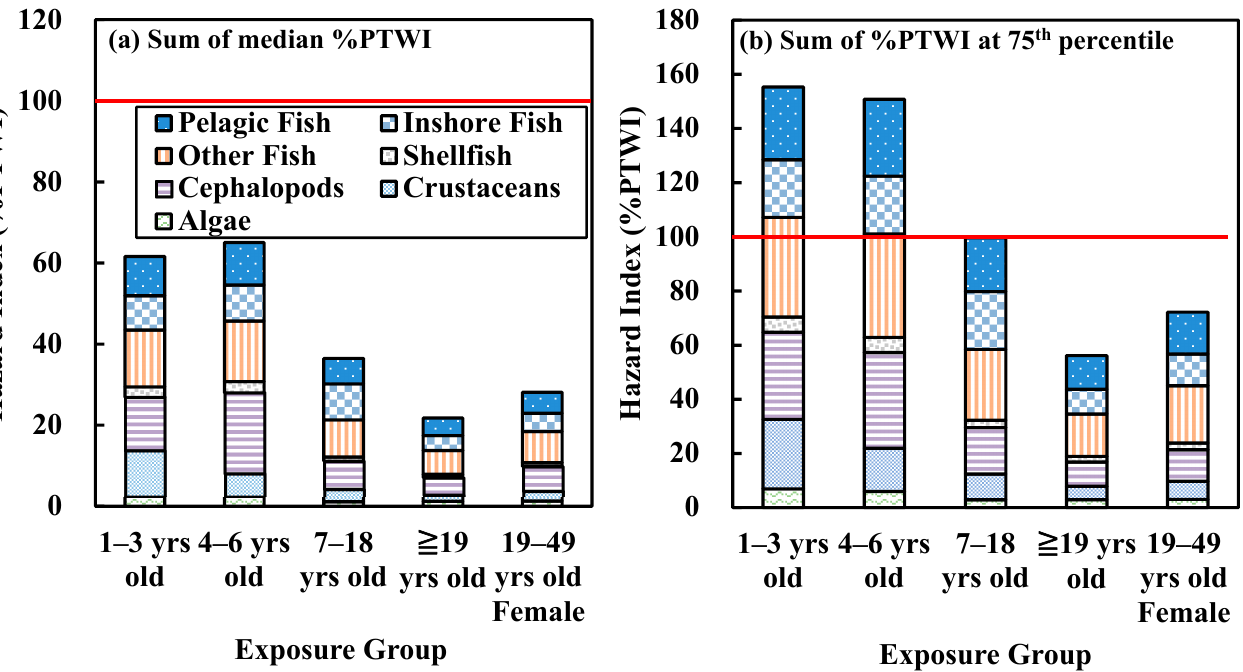
Figure 3. Hazard index of dietary exposure to MeHg in seafood for different age groups. ( a ) Sum of all median 100%PTWI, ( b ) Sum of all 100%PTWI at 75th percentile.